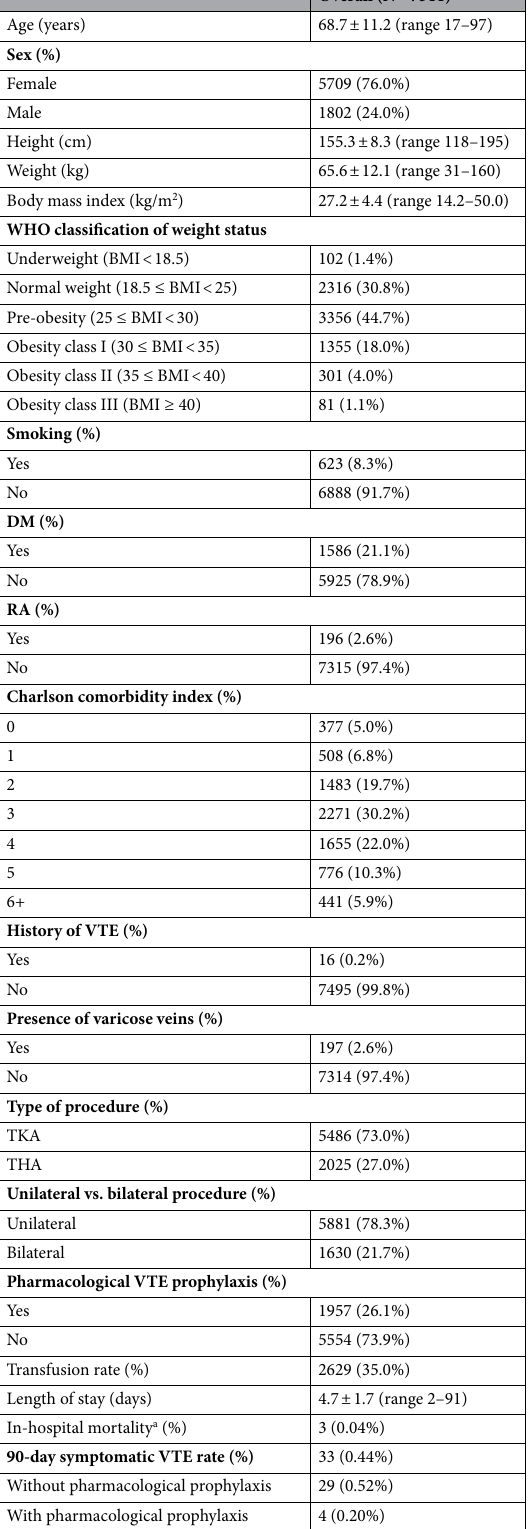
Table 1. Patient demographics. DM: diabetes mellitus; RA: rheumatoid arthritis; THA: total hip arthroplasty; TKA: total knee arthroplasty; VTE: venous thromboembolism. a In-hospital mortality: ischemia bowel, Perforated peptic ulcer disease with sepsis, Acute myocardial